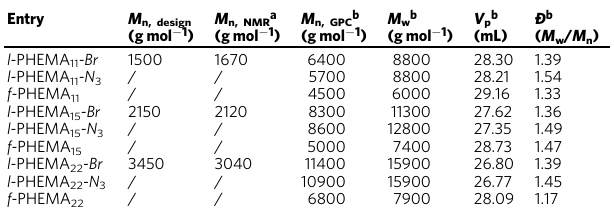
Table 1 Characteristics of linear and folded PHEMA samples. Entry